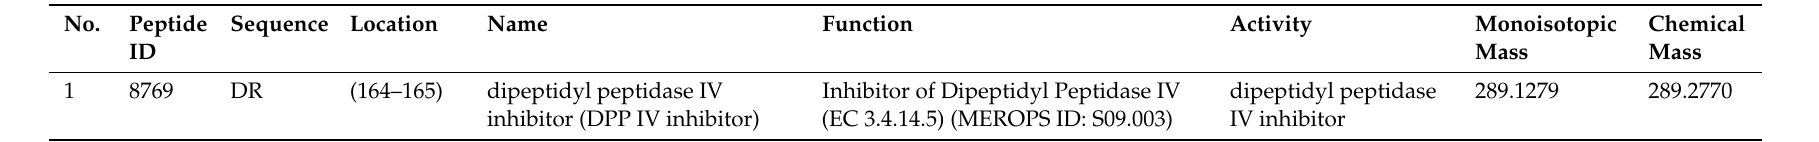
Table A23. Bioactive peptides from RubisCO of Halophila stipulacea . In silico enzymatic cleavage was carried out by using clostripain.